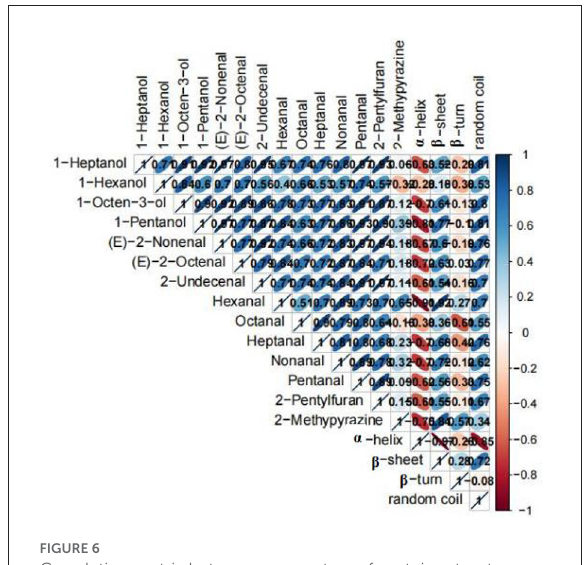
FIGURE6 Correlation matrix between parameters of proteins structures ( α -helix, β -sheet, β -turn, and random coil) and key aroma